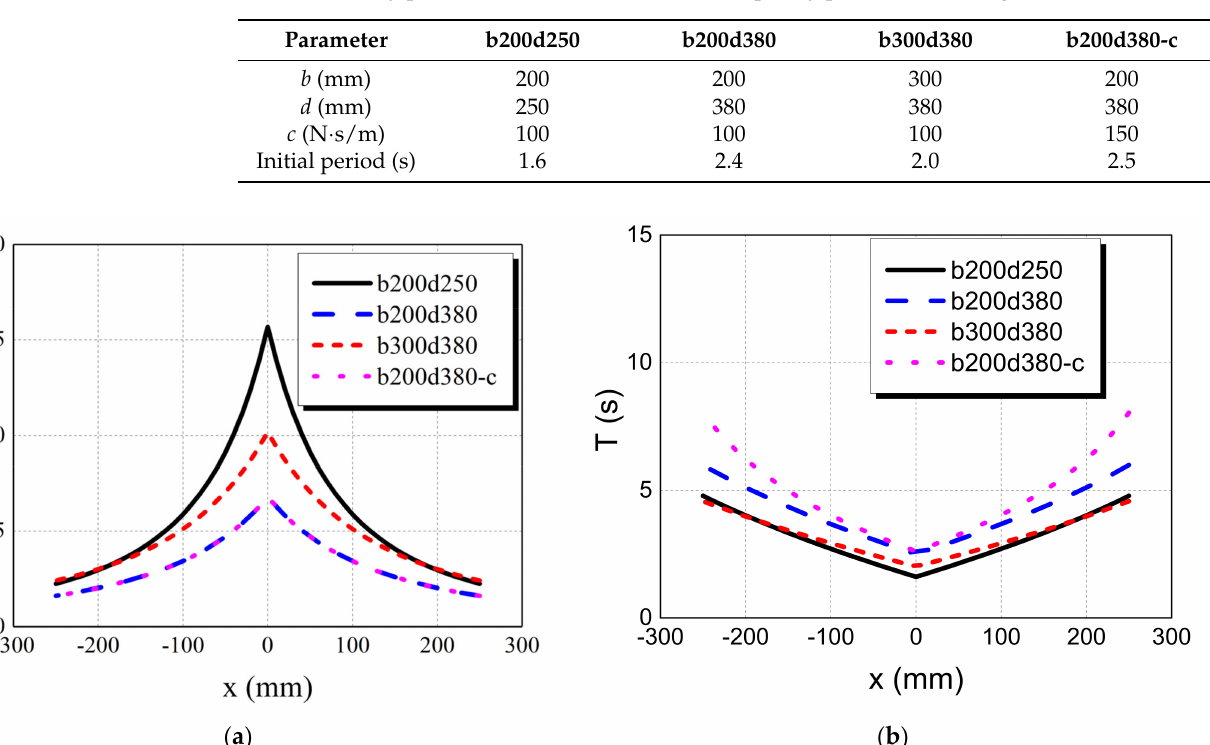
Table 2. The key parameters of the four variable-frequency pendulum bearings.